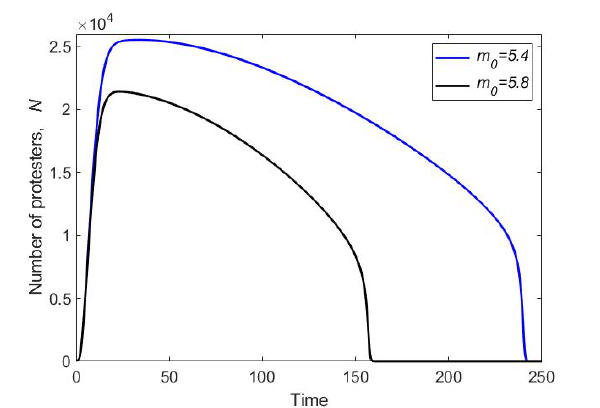
Figure 7. Total number of protesters vs. time as given by the solution of Model (8) obtained for m 0 = 5.4 (blue curve) and m 0 = 5.8 (black curve). Other parameters are the same as in Figure